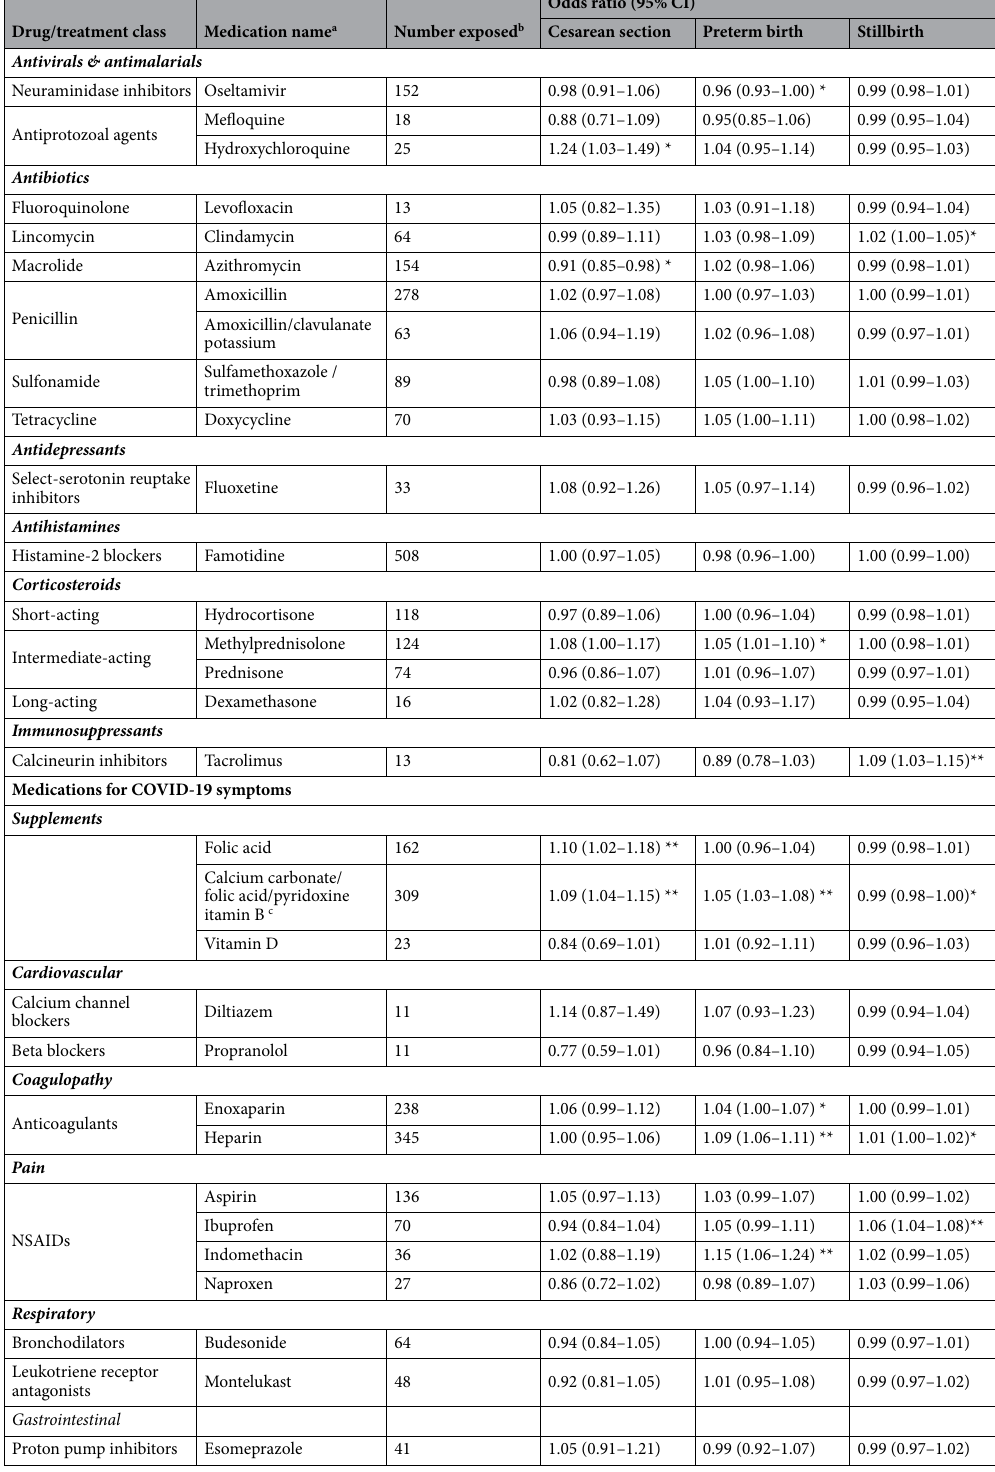
Table 2. Medications that potentially be repurposed for COVID-19 and their effects on pregnancy outcomes. a Medication names listed are generic names, although some patients were on brand name medications while others were on generic and these were merged based on common active ingredients. b The number of pregnancies exposed to the generic medication during the observed prescription window (280 days before delivery up to 1 day before delivery). All pregnancies, exposed and none-exposed were included in the analysis. c Medication contains other active ingredients. *Nominal P -value < = 0.05. **Nominal P -value & P -value with Bonferroni adjustment < =